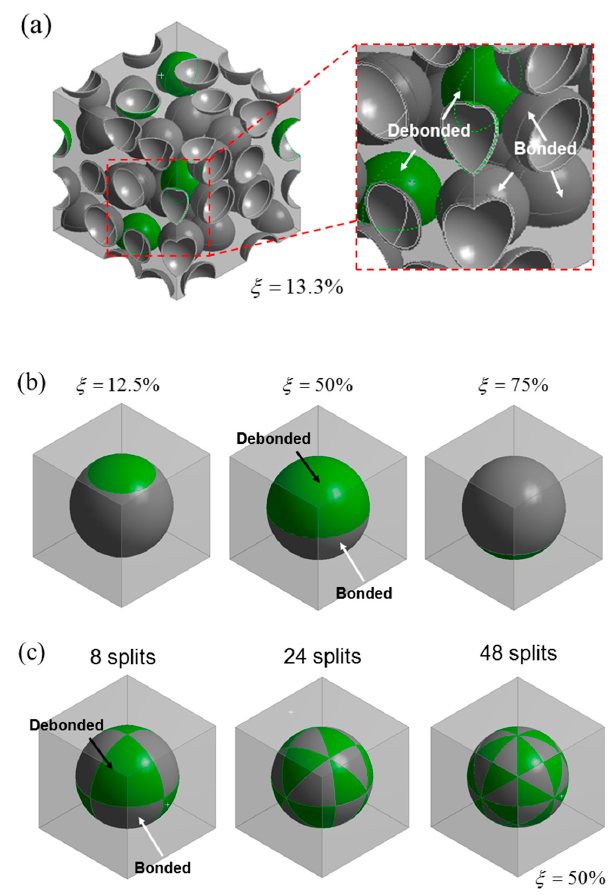
Figure 2. ( a ) Model geometry for the mixed model, with 30 randomly distributed microspheres, showing the debonded geometry for a debonding fraction of 13.3% (four microspheres out or a total of 30 microspheres are debonded); ( b ) Representative model geometries of the partially debonded model for ξ = 12.5%, 50% and 75%; ( c ) Model geometries for the discontinuously bonded